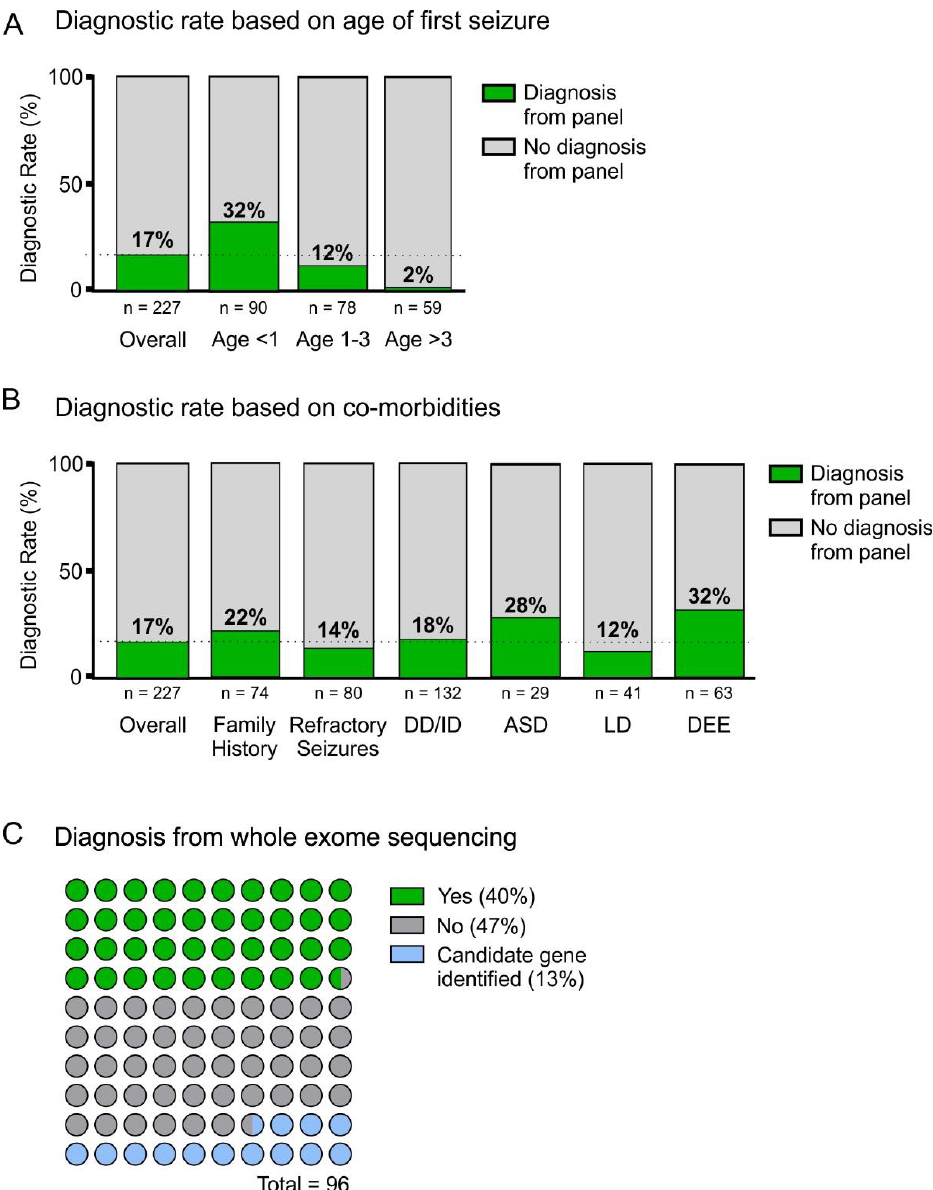
Figure 4. Diagnostic rate in patient sub-groups. ( A , B ) Diagnostic rate of epilepsy panel testing comparisons with overall rate of 17% (dotted line) grouped by age of onset of seizures. ( A ) All age groupings; comparison among groupings showed a significant difference, χ 2 (2, n = 227) = 25.99, p < 0.0001. ( B ) Frequency of diagnoses by co-morbidities. For family history, χ 2 (1, n = 227) = 5.57, p = 0.018; Refractory seizures χ 2 (1, n = 227) = 0.41, p = 0.52; DD/ID χ 2 (1, n = 227) = 0.686, p = 0.41; ASD χ 2 (1, n = 227) = 2.53, p = 0.112; LD χ 2 (1, n = 227) = 0.874, p = 0.35; DEE χ 2 (1, n = 227) = 13.00, p = 0.0003. Only DEE was significant after consideration of multiple comparisons. ( C ) Dot plot representing results of whole exome sequencing (WES, n = 96). WES identified a genetic diagnosis in 40% of patients tested and a candidate VUS in an additional